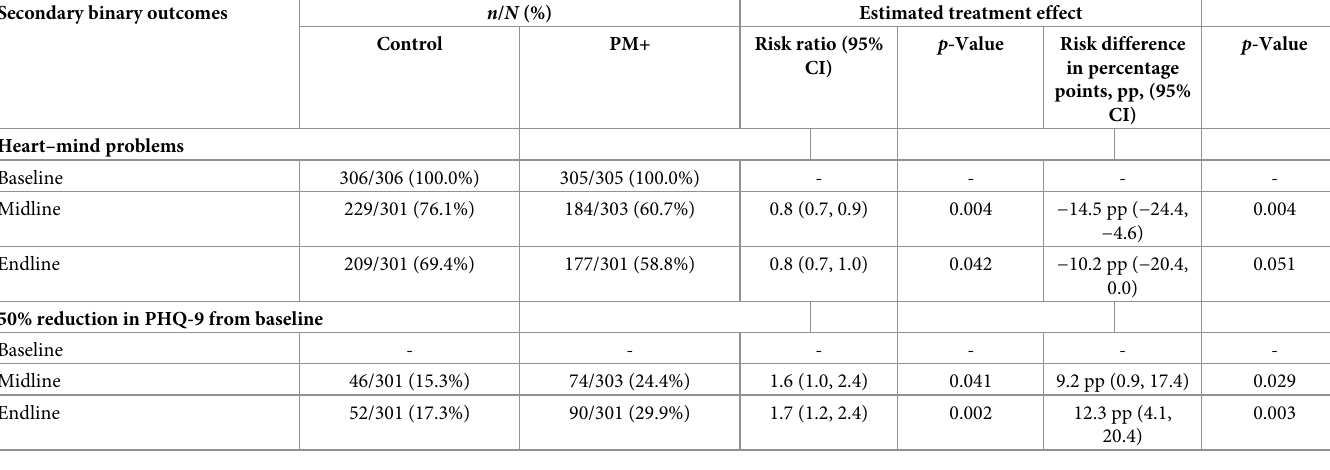
Table 5. Intervention effects a on secondary binary outcomes (risk ratios and risk differences with 95% confidence intervals for the ITT population).